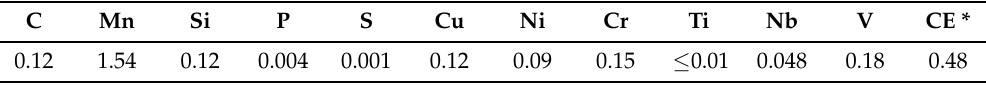
Table 1. Chemical composition (weight percent: wt %) of the investigated steel.